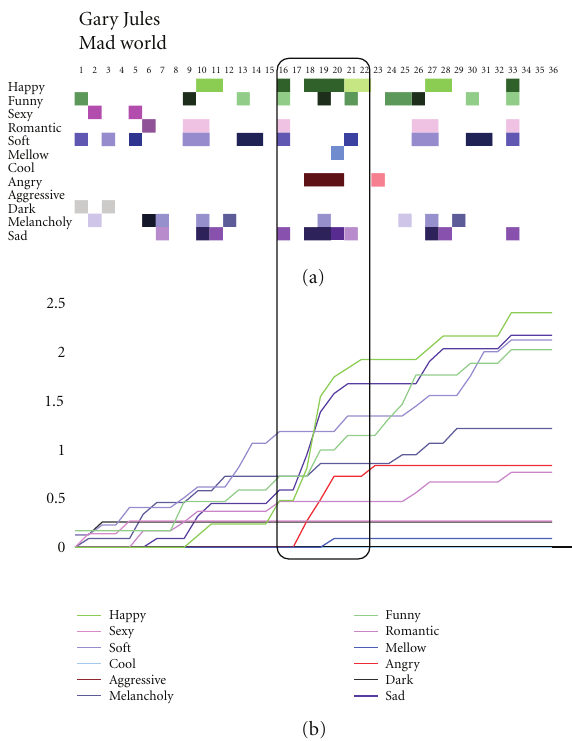
Figure 6: Summed up values of LSA correlation between (a) the lyrics of the song “Mad world” and 12 a ff ective terms, with (b) accumulated values plotted over the entire length of the